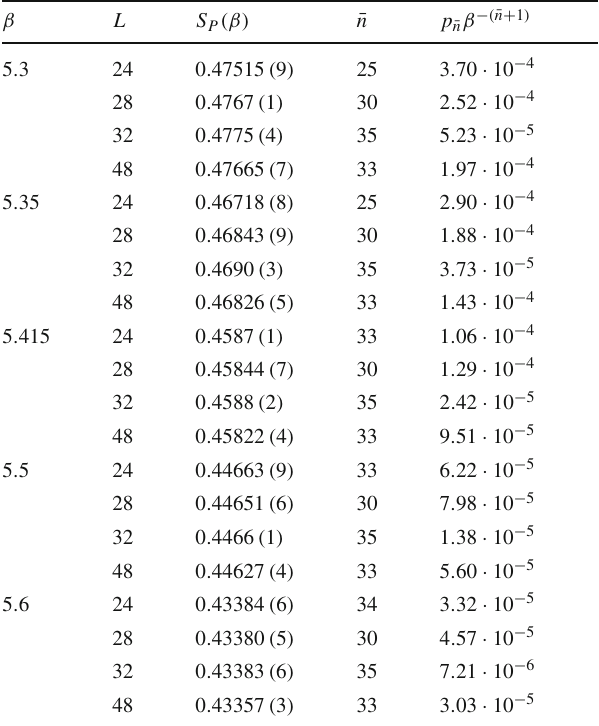
Table 5 Summation up to the minimal term of the perturbative series of the